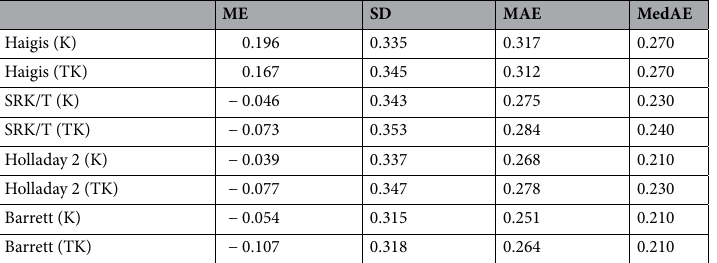
Table 2. Refractive mean error, mean absolute error, and median absolute error, according to each formula, using conventional keratometry or total keratometry. ME mean error, SD standard deviation, MAE